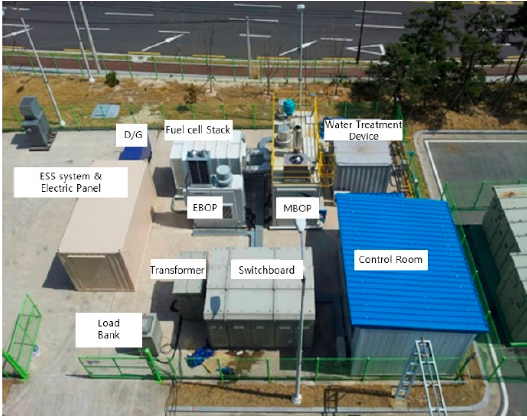
Figure 3. Actual placement of the test bed.